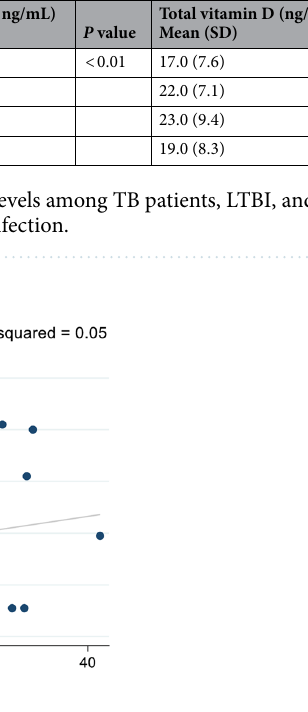
Figure 1. Correlation of bioavailable total vitamin D levels in ATB, LTBI, and individuals with no TB